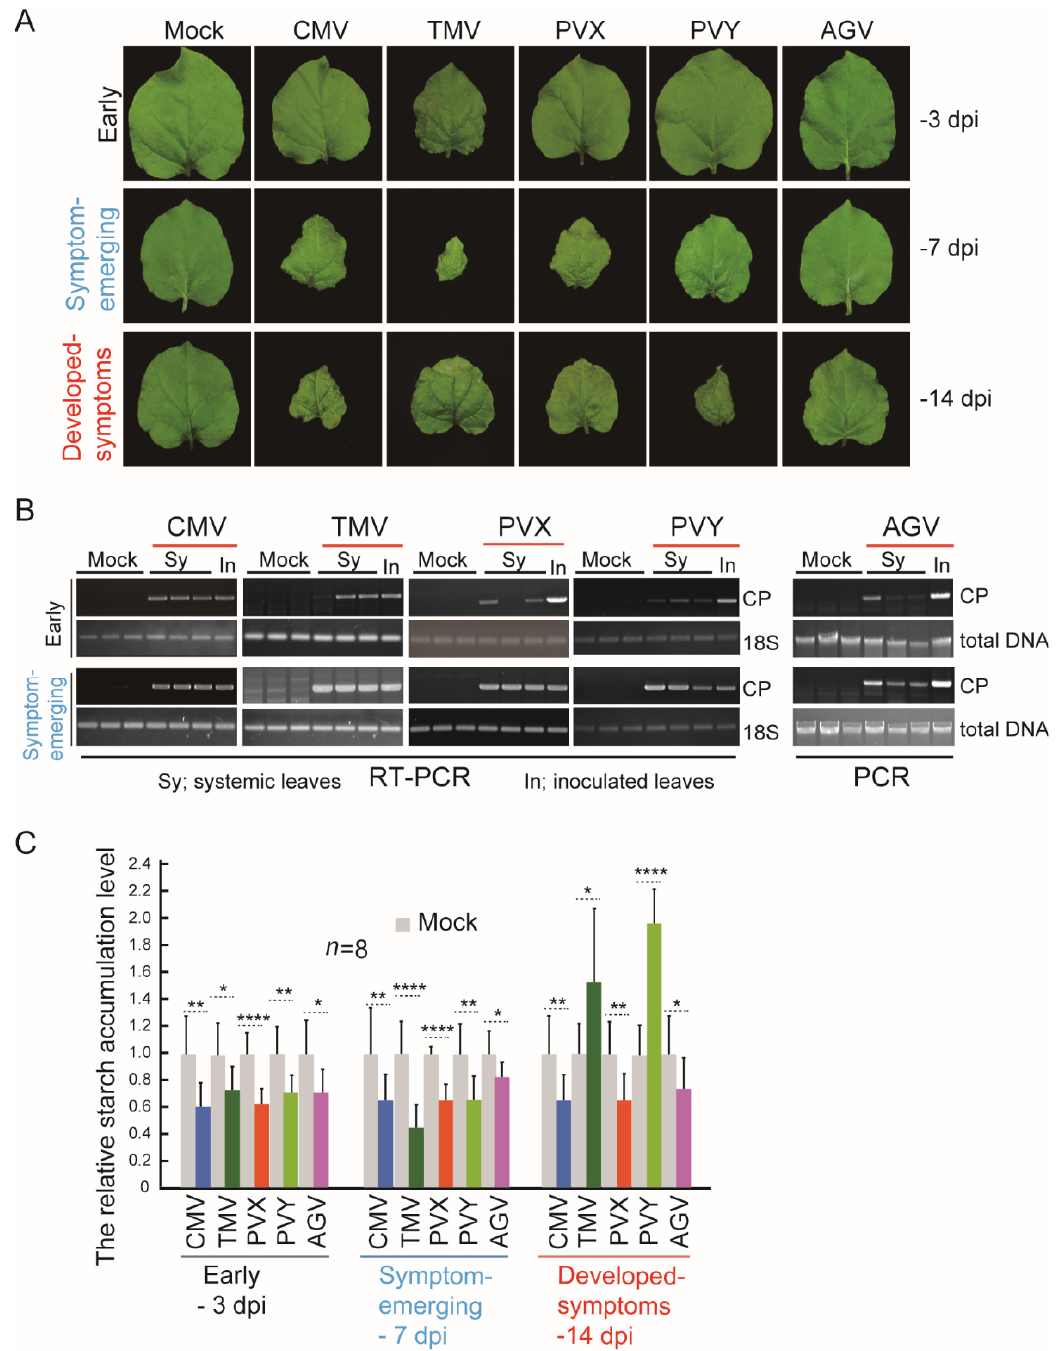
Figure 1. Effects of plant virus infection on starch accumulation levels. ( A ) Virus symptom pheno- types on the N. benthamiana leaves collected for starch content analysis and RT-PCR. ( B ) RT-PCR detection of viruses in the plants described in ( A ) using primer sets specific for the viral coat protein gene. Amplification of N. benthamiana 18S was used as a control standard. PCR products are separated on agarose gels via electrophoresis and stained with ethidium bromide (EtBr) ( C ) The relative starch accumulation in the leaves described in ( A ). Data are presented as mean ± SD. The mock sample data value was set to 1.0. *, ** and **** indicate a significant difference at p < 0.05, 0.01, 0.001, or 0.0001, respectively (Student’s t -test).